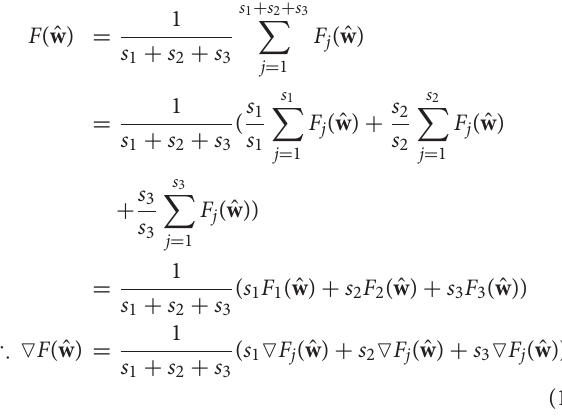
Algorithm 5 (Ming et al., 2017) details the steps